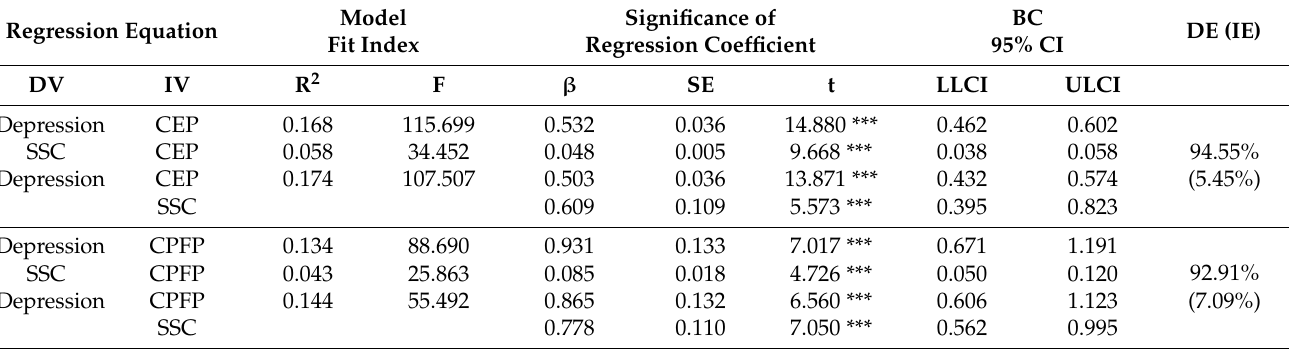
Table 4. Results of hierarchical regression